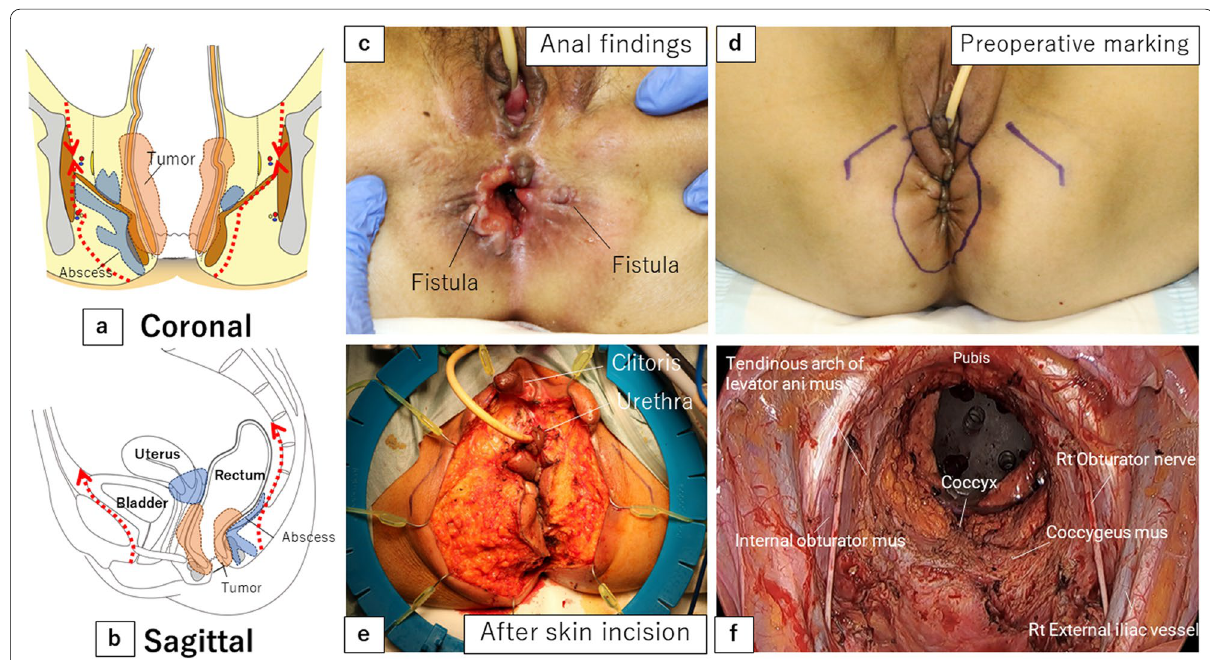
Fig. 2 Preoperative and intraoperative findings. a , b Schema of the resection area. The abscess extends to the right side, and the perineum was extensively resected on the right side. Orange area, tumor. Blue area, abscess. Red line, resection line. c Preoperative anal findings: fistulas are present at 3 and 9 o’clock. d Preoperative marking of the resection line. e After skin incision. f After removal of a